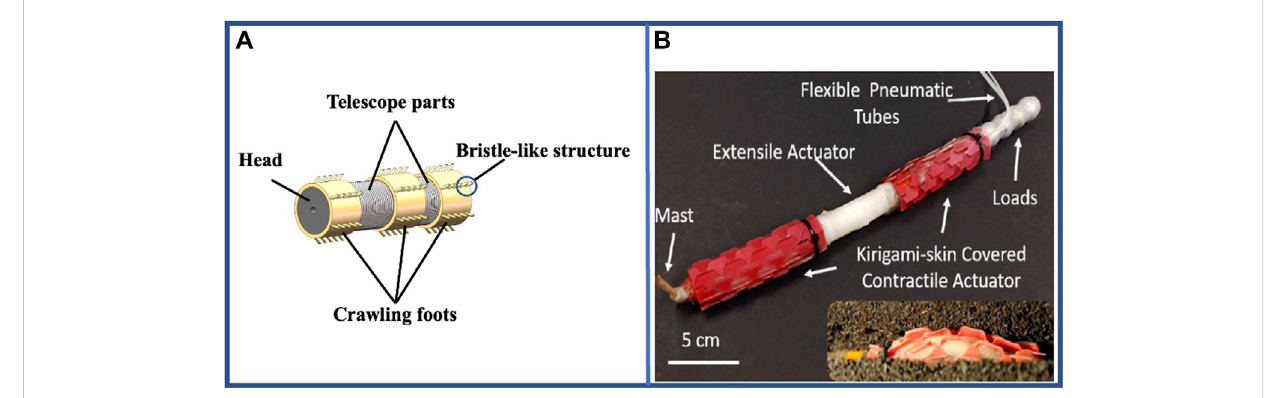
FIGURE 9 Examples of pneumatic-driven multi-segment earthworm-inspired soft robot for surface crawling and related new structures and applications. (A) Modelofthetypicalsoftrobotforsurfacecrawling. (B) Earthworm-inspiredsoftrobotwithKirigamiskin(Liuetal.,2019).Reproduced fromRef.(Liuetal., 2019). with permission.